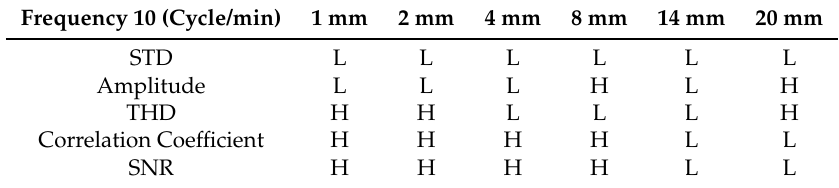
Table A12. Values higher and lower than the median Frequency 10 cycles/min for a 5 mm band.